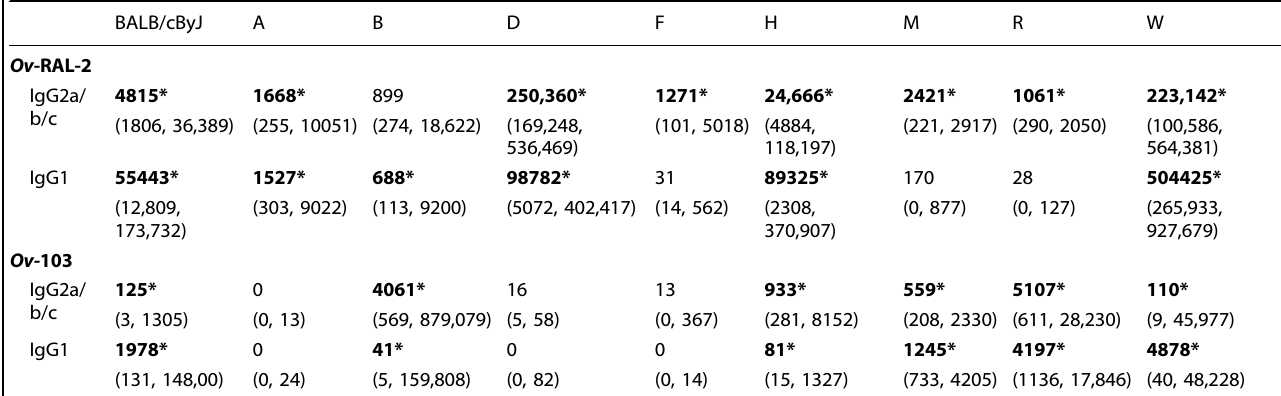
Table 5. Antigen-speci fi c antibody endpoint titers measured in BALB/cByJ and 8 CC-RIX Lines serum following vaccination and challenge.